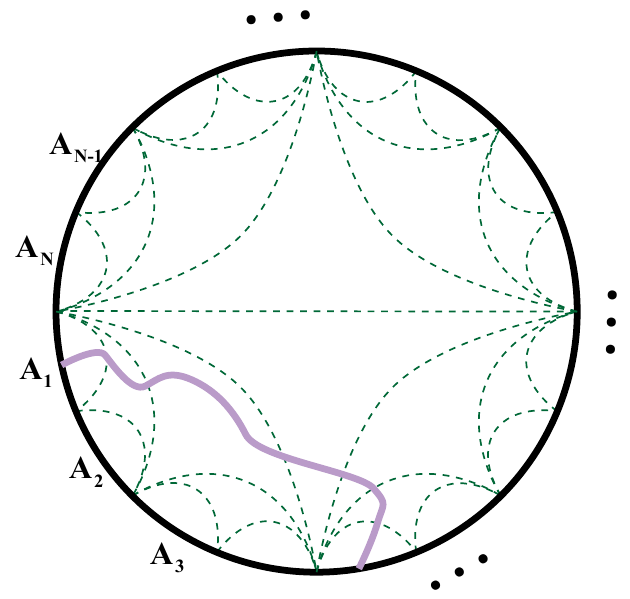
Figure 6 . The holographic qubit threads model. The boundary quantum system is divided into extremely large N elementary regions (of the same size), which introduce N ( N − 1) / 2 independent thread bundles (or component flows) ~v ij . We only present one of these thread bundles in the figure, represented by a thick mauve line. Furthermore, the component flow fluxes should satisfy (4.3). Again, the green dashed lines represent RT